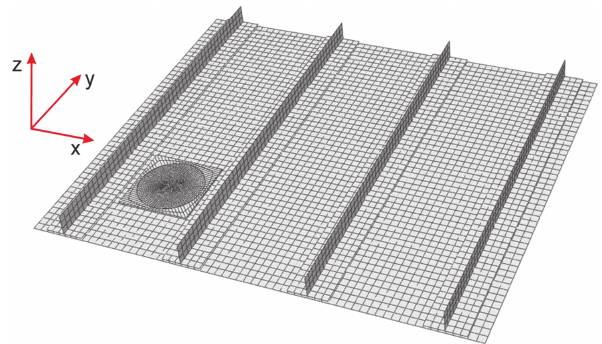
Figure 3 FEM model of the stiffened panel with the embedded artificial delamination at the lower left side.